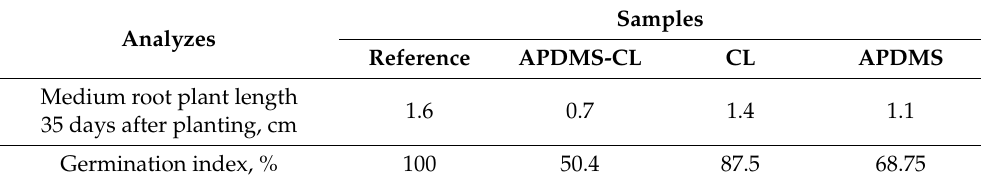
Figure 7 . Tomato plants 7 days after planting . Figure 7. Tomato plants 7 days after planting. Table 1. The average length of plant roots and germination index.